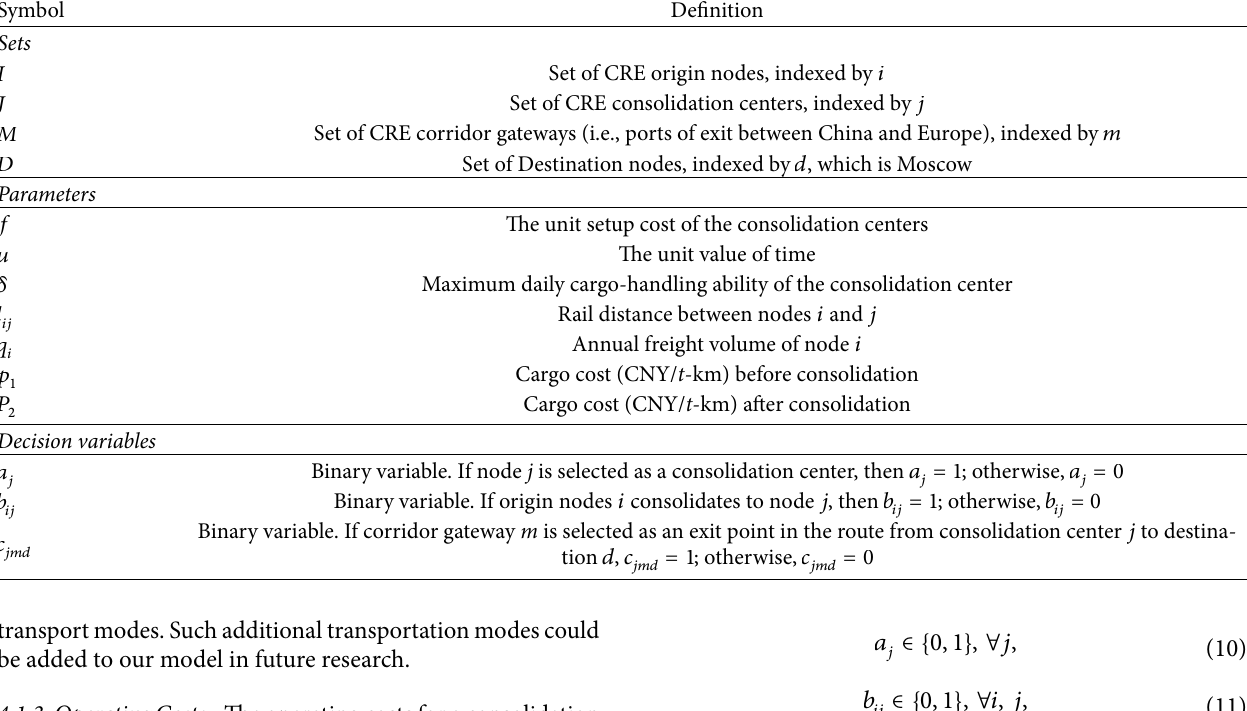
Table 3: Parameters and variables used in the CRECN